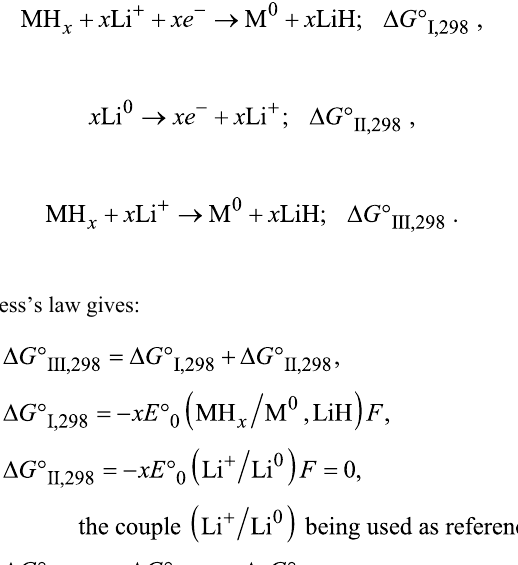
Figure 2: Theoretical equilibrium potential for the MH x /Li cell vs Li + /Li 0 . a) For binary hydrides M = Y, La, Ba, Ca, Zr, Ti, Na, Cs, Mg. Inset: Gibbs free formation enthalpy of these hydrides as a function of the equilibrium potential. b) For ternary hydrides Mg 2 NiH 4 , LaNiH 4 , CoTiH 1.4 , TiFeH 2 , ZrV 2 H 5.1 , ZrCr 2 H 3.8 , ZrMn 2 H 3.6 , TiMn 1.5 H 2.5 , TiCr 1.8 H 3.5 , LaNi 5 H 6 , LaNi 4 MnH 5